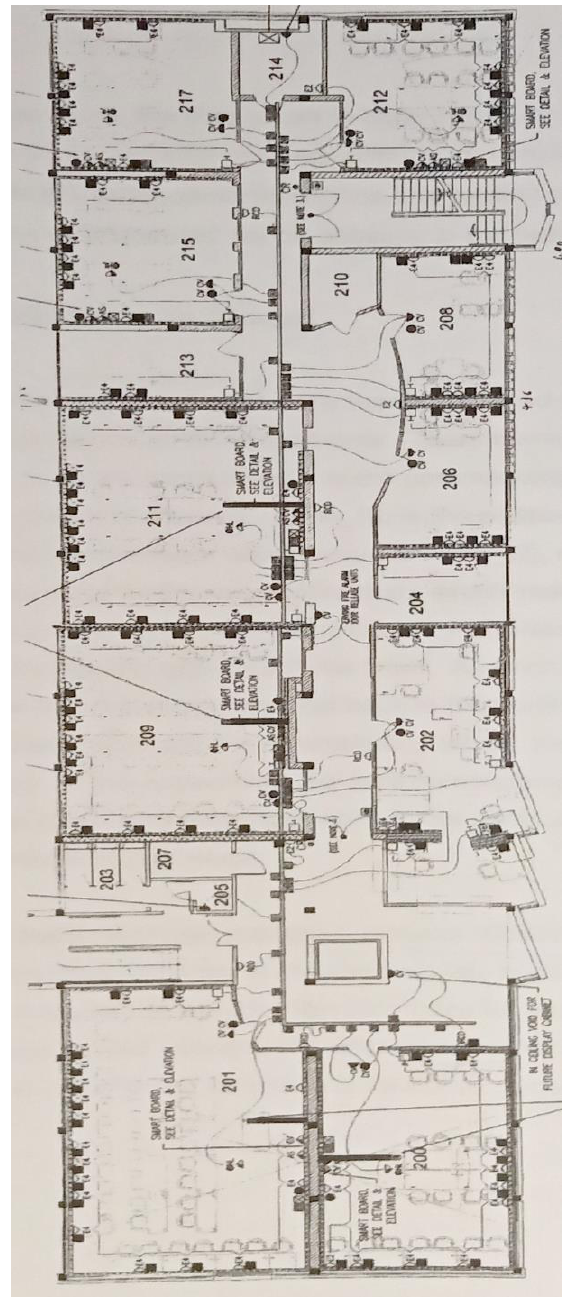
Figure 3. Floor plan for original operation.